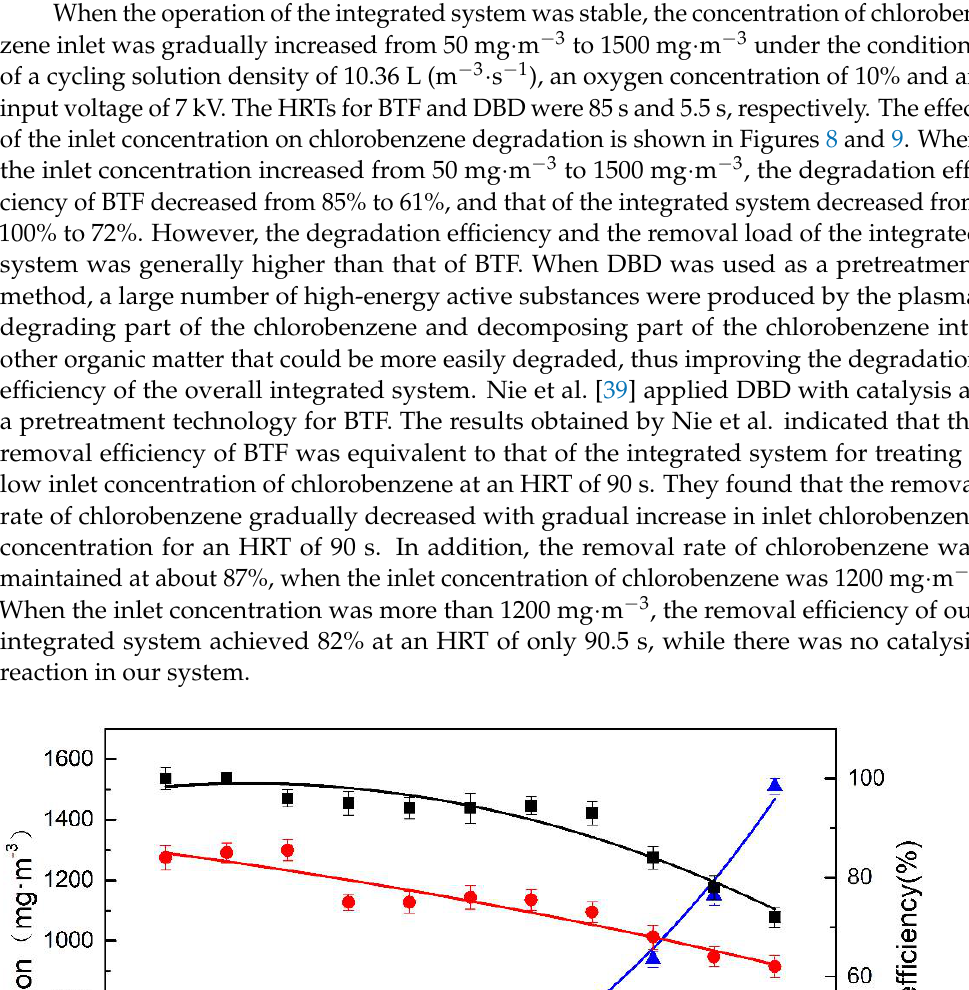
Figure 9. Comparison of chlorobenzene removal load between the integrated system and a separate biofiltration system (● Degradation efficiency of a single biofilter system, ■ Degradation efficiency of integrated system) (cycling solution density = 10.36 L·(m −3 ·s −1 ), oxygen concentration = 10%, input voltage = 7 kV, HRT of the BTF = 85 s, HRT of the DBD = 5.5 s.).